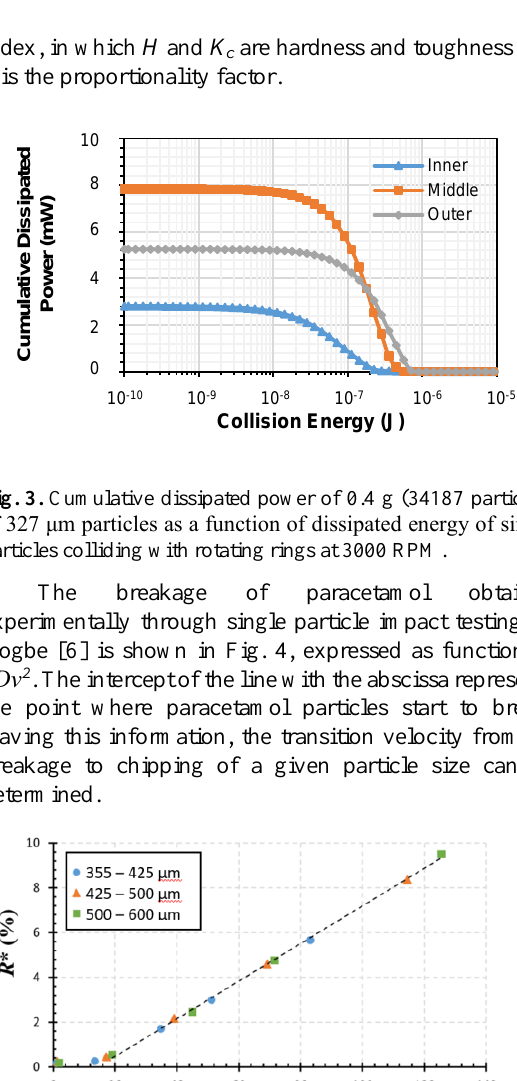
Fig. 5. Particle energy spectra of 327 μm particles; (a): normal impact and shear in a pin mill rotating at 6000 RPM; (b): normal impact only at different RPMs. The solid and dashed vertical lines represent the minimum breakage energy of paracetamol particles and the maximum incident kinetic energy for 327 μm particle size and the given RPM. NB : the energy spectra curve for 30000 RPM is trimmed off from the top to better show the difference amongst different RPM.